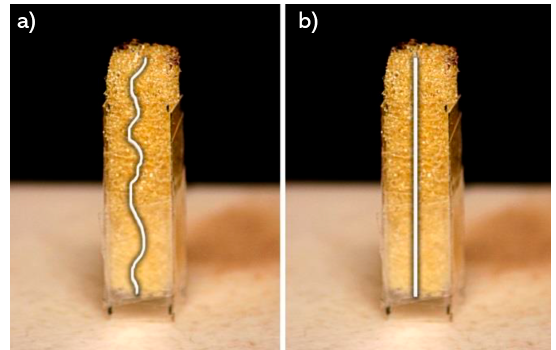
Figure 11. ( a ) Length of path ( l P ) traced by the fluid through porous media; ( b ) length of path ( l ) by the fluid without porous media (sample length).